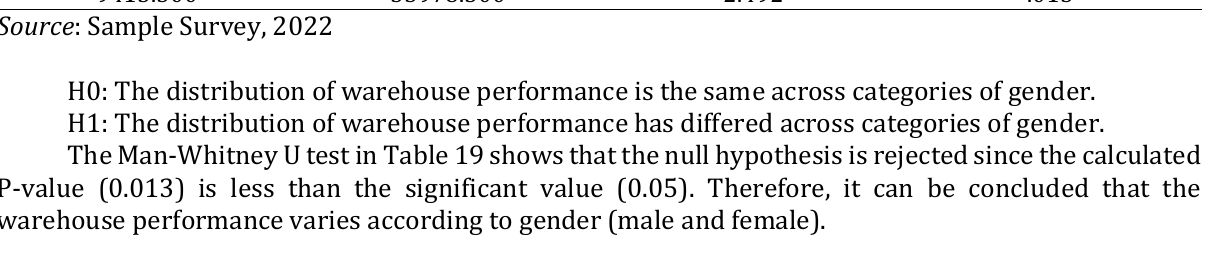
Table 19: Mann-Whitney U test Mann-Whitney U